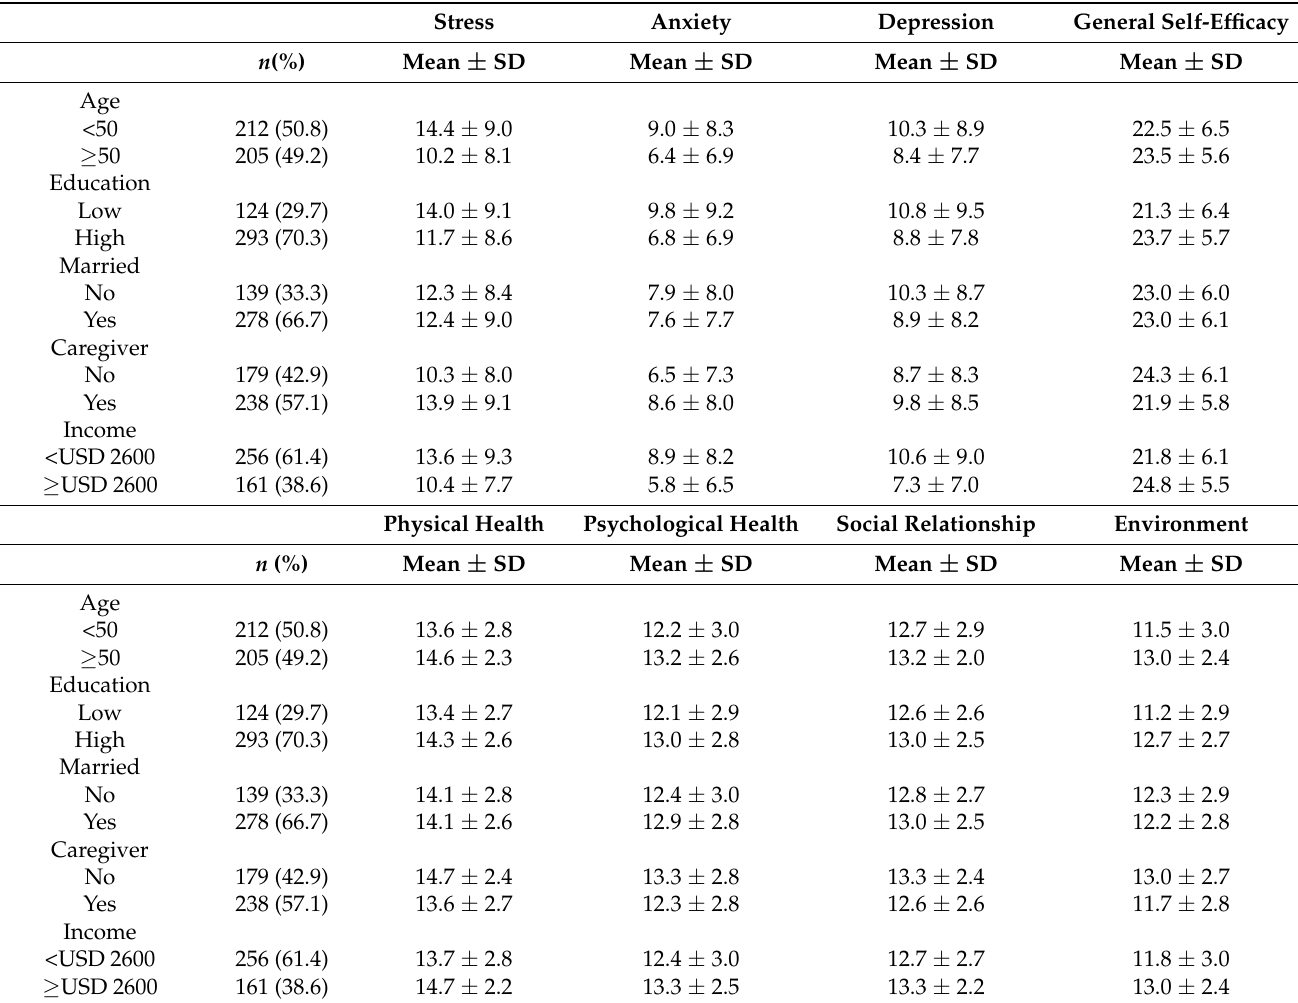
Table 2. Descriptive statistics of demographic variables, emotional states, general self-efficacy, and four domains of the quality of life ( n = 417).